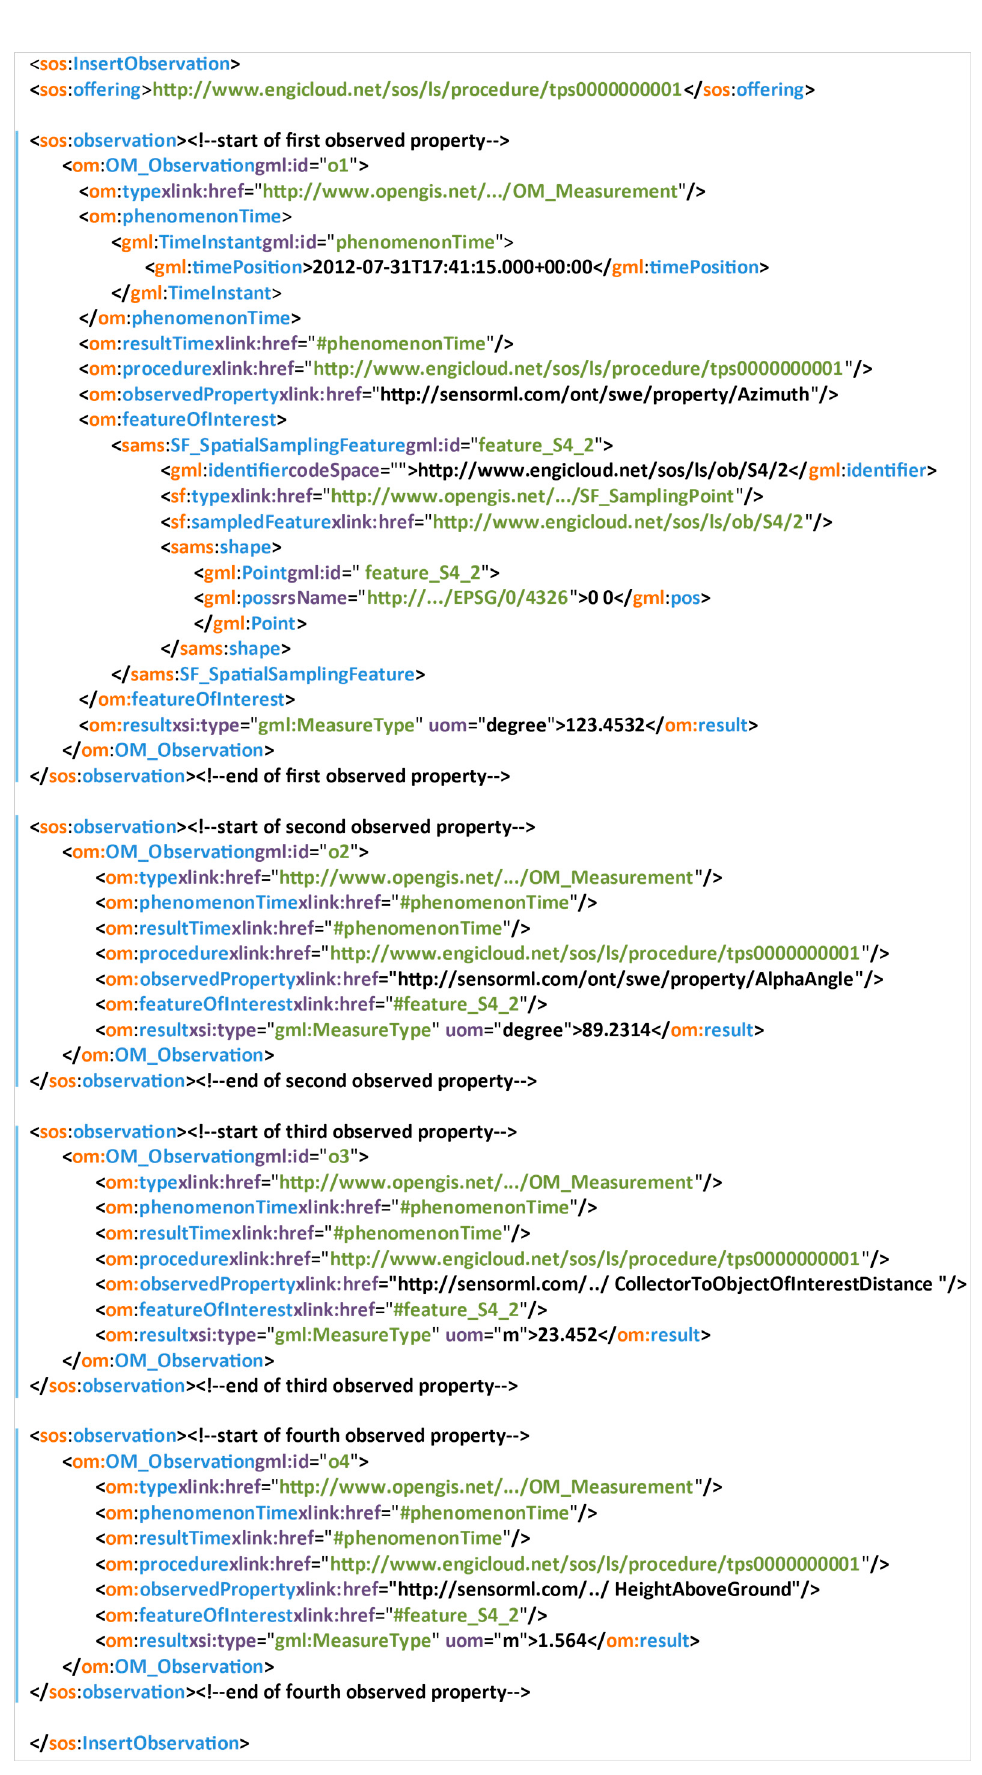
Figure 11. Insert observation XML request data.